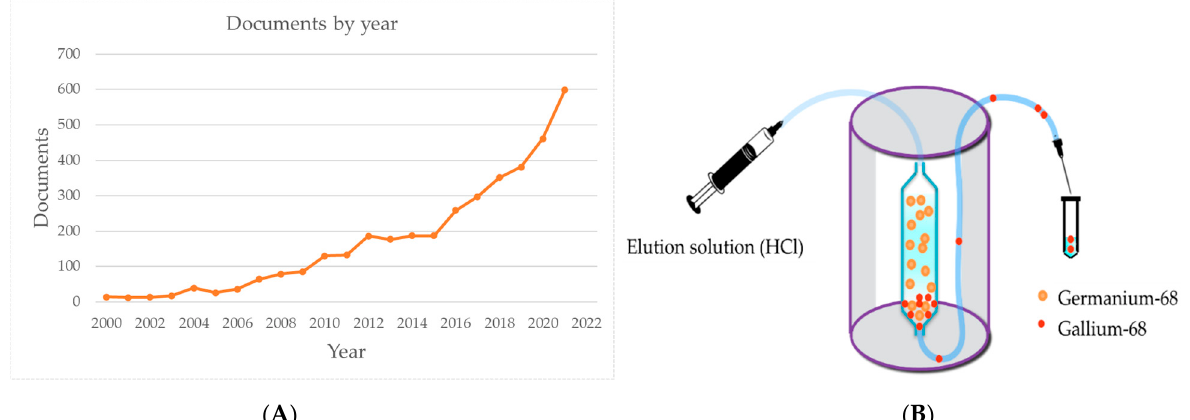
Figure 1. ( A ) Number of documents by year related to 68 Ga-based on Scopus search; ( B ) Illustration of 68 Ga radionuclide elution from 68 Ge/ 68 Ga generator using hydrochloric acid (HCl). Arrow indicating flow of eluate.